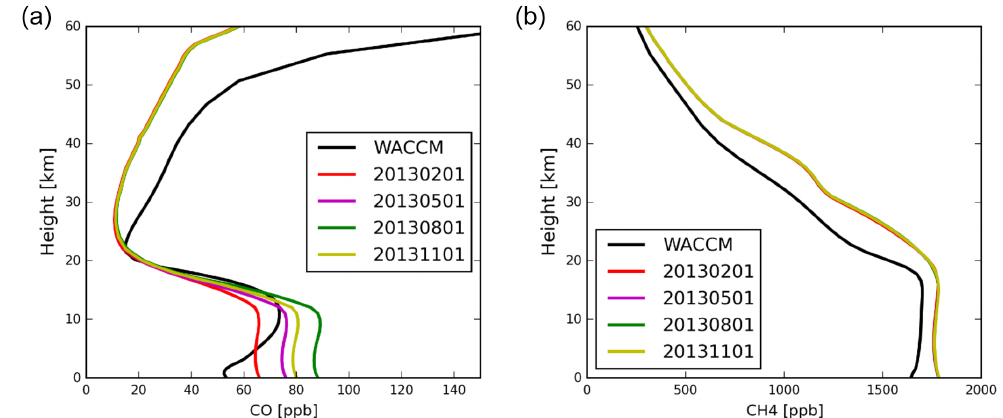
Figure 1. The a priori profiles used for TCCON measurements on 20130201 (year, month and day), 20130501, 20130801, 20131101 and NDACC measurements for CO (a) and CH 4 (b) . Note that NDACC uses a fixed a priori profile from WACCM model for all retrievals.